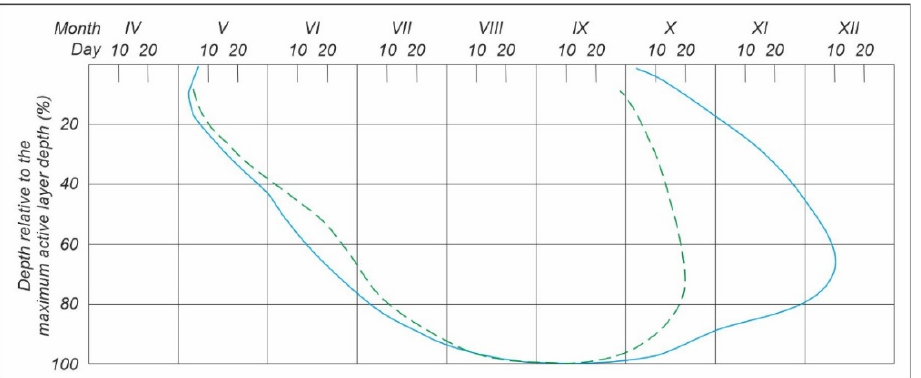
Figure 1. Seasonal freezing and thawing curves in 1938–1958; solid line—averaged curve for well- drained soils in the suburban landscapes with natural vegetation (meadows and sparse forest); dashed line—averaged curve for soils within the historical urban development limits (compiled based on [18]).